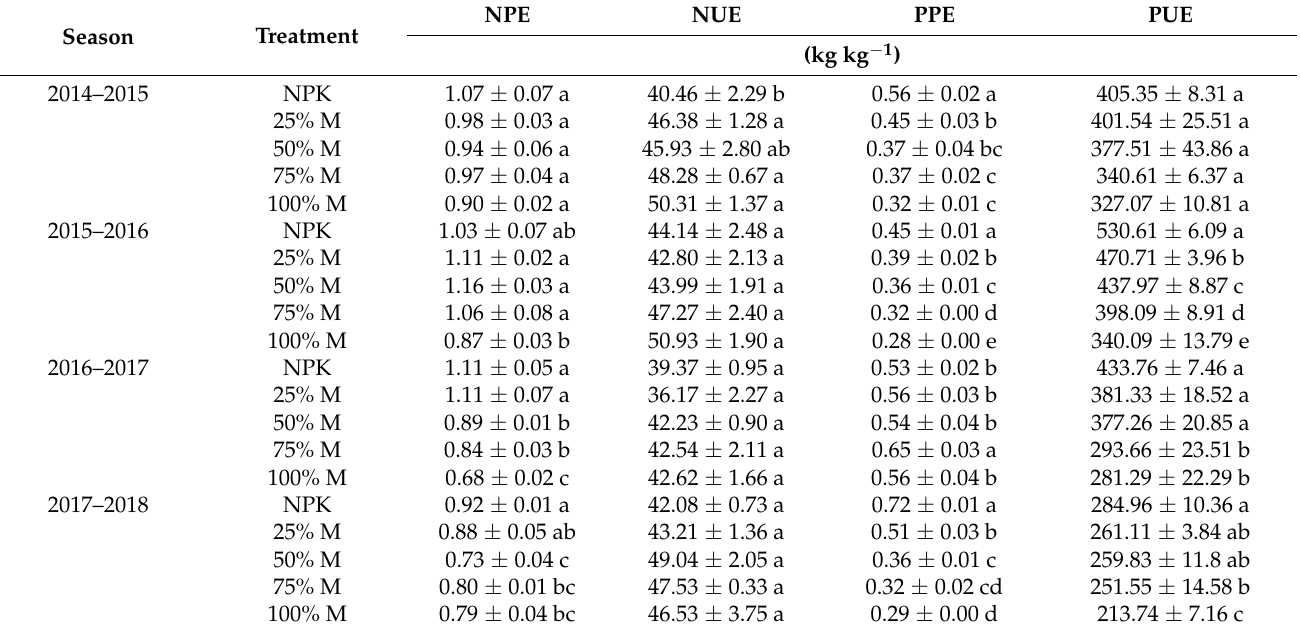
Table 2. Effect of year and treatment on nitrogen uptake efficiency (NPE), nitrogen use efficiency (NUE), phosphorus uptake efficiency (PPE) and phosphorus use efficiency (PUE), of winter wheat– summer maize cropping system during 2014–2020.